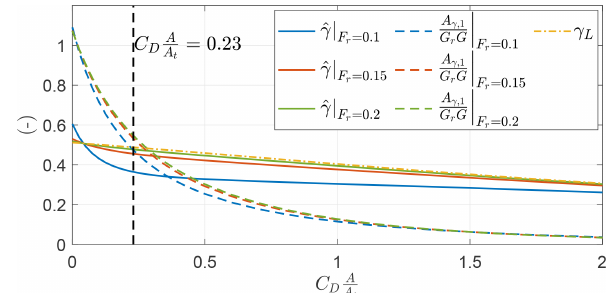
Figure 20. Optimal shaft power production and consumption P s and thrust power P t as a function of the angular position.